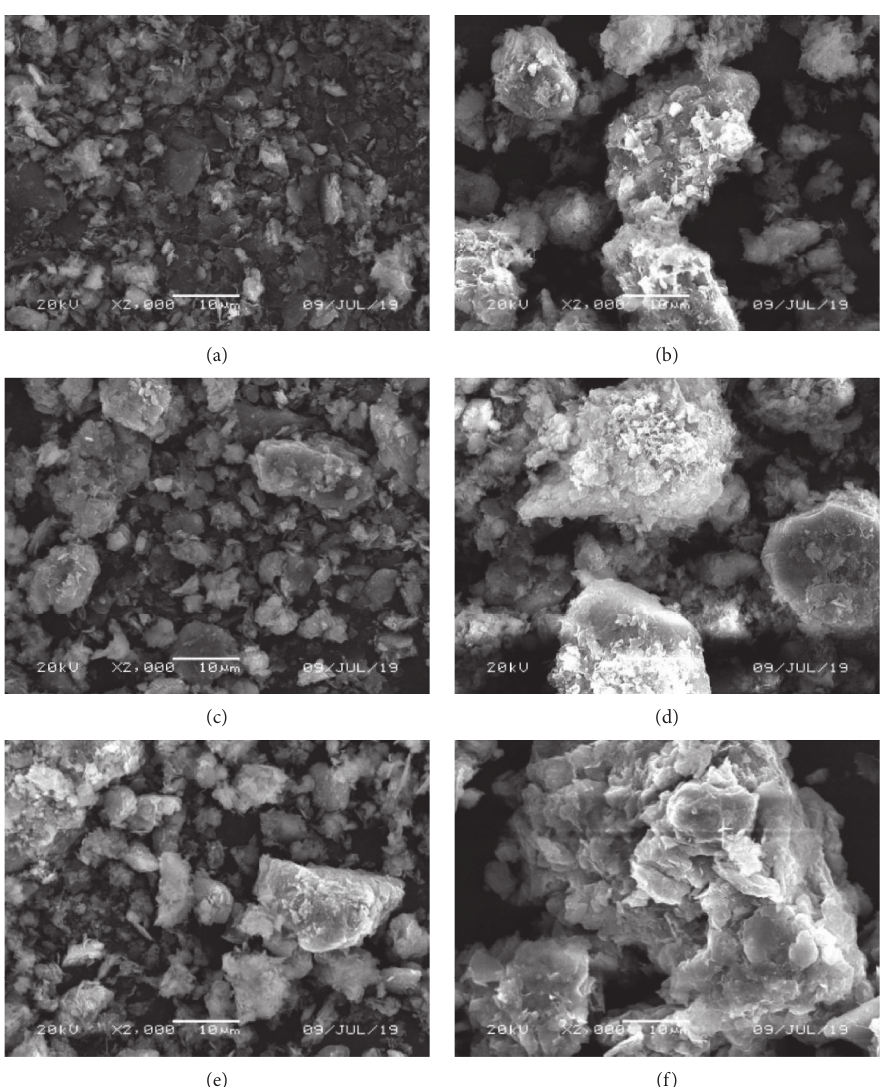
Figure 15: SEM images of CMS with different cement contents and curing ages. (a) Cement content 5% and curing age 7(d). (b) Cement content 20% and curing age 7(d). (c) Cement content 5% and curing age 28(d). (d) Cement content 20% and curing age 28(d). (e) Cement content 5% and curing age 90(d). (f) Cement content 20% and curing age 90 d.